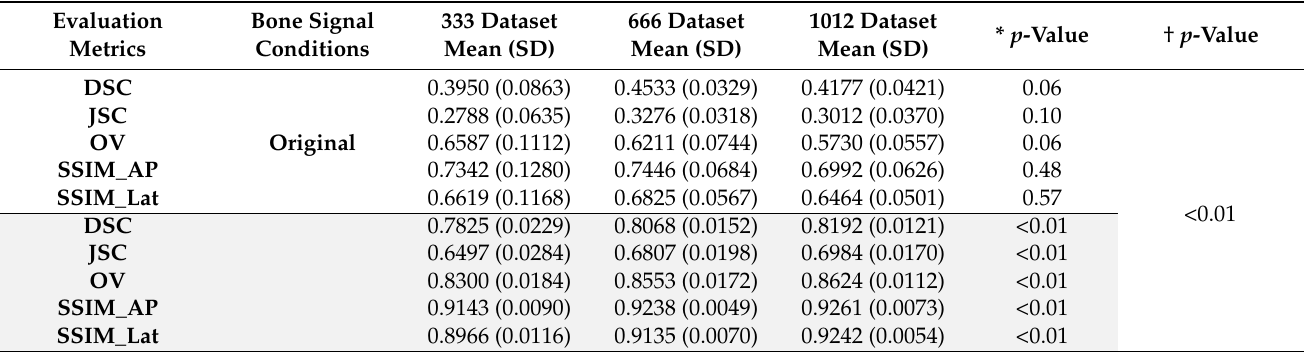
Table 4. Evaluation metrics of different training conditions.